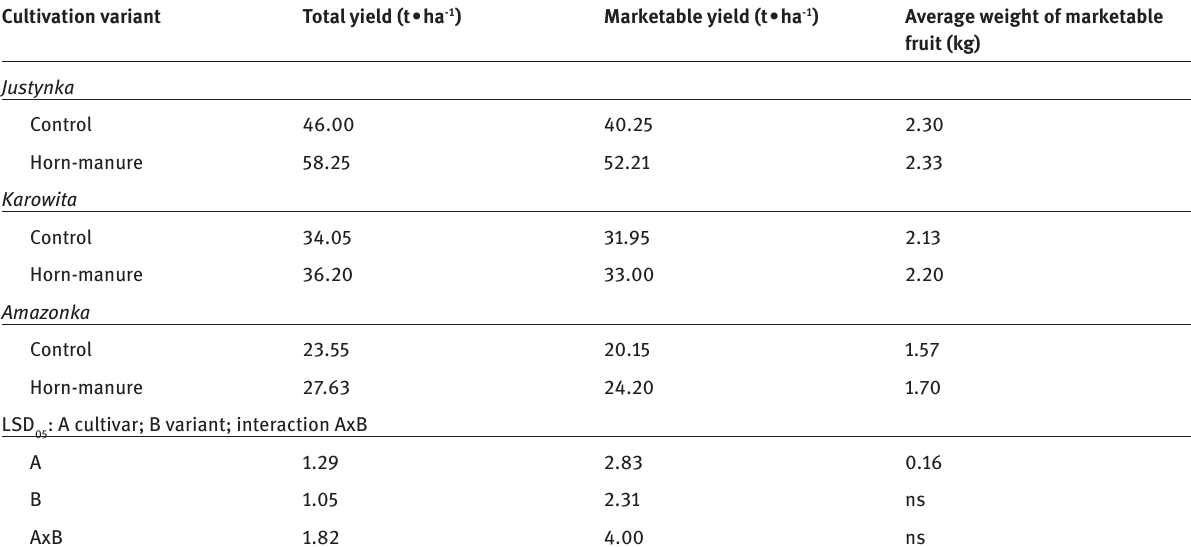
Table 3: The effect of spraying with horn-manure preparation on great pumpkin yield Cultivation variant